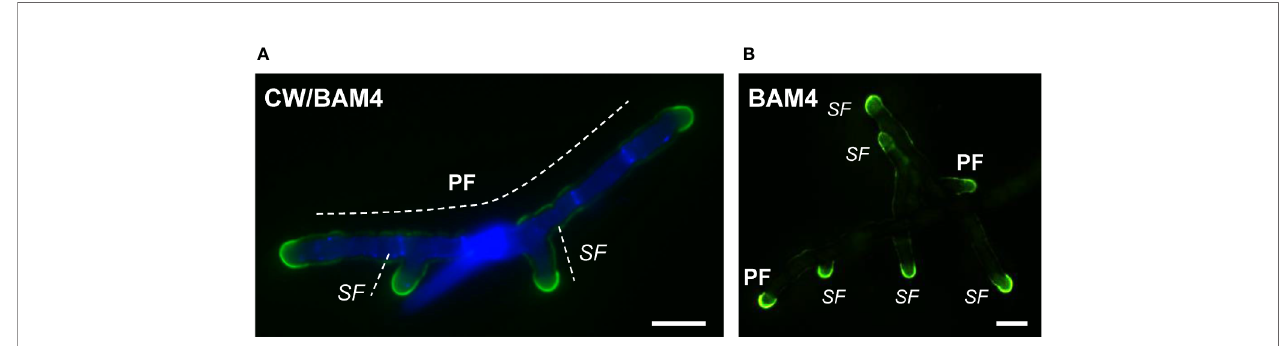
FIGURE 3 | Immuno fl uorescence detection of the BAM4-fucan epitopes in E. subulatus fi laments cultivated in 10% NSW. Micrographs showing fi laments after 7 days (A) and 15 days (B) of development, respectively. The BAM4-binding (green fl uorescence) is preferentially located at the apical cells. Cellulose was detected by Calco fl uor White (blue fl uorescence) in all cells expect at the tips. Micrograph in (A) shows the overlaid picture of the signals gained from the two channels, while (B) shows the green fl uorescence only. PF = primary fi lament, SF = secondary fi lament. Scale bar =